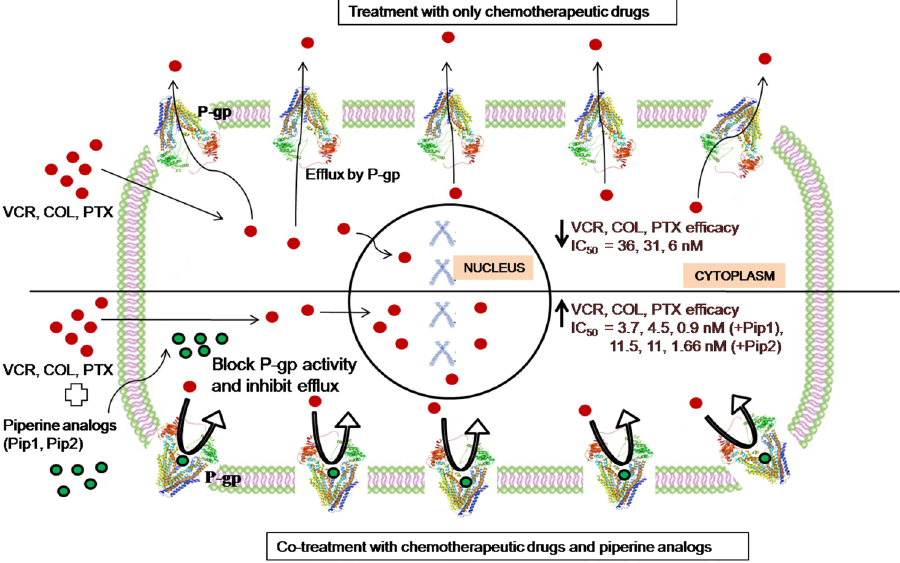
Figure 12. Pictorial representation showing how piperine analogs increased the efficacy of chemotherapeutic drugs in P-gp overexpressing resistant cancer